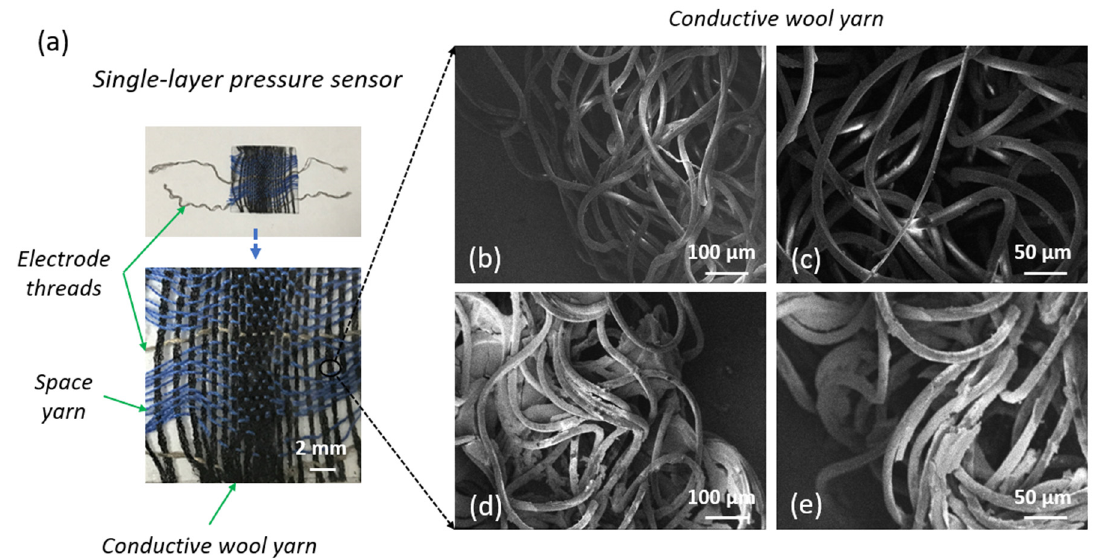
Figure 2. ( a ) Single-layer pressure textile sensor, ( b ) nonconductive wool yarn at 100 µ m, ( c ) nonconductive wool yarn at 50 µ m, ( d ) conductive wool yarn at 100 µ m, and ( e ) conductive wool yarn at 50 µ